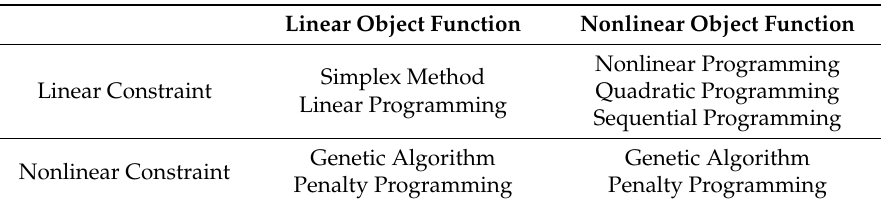
Table 1. The Optimization Scheme